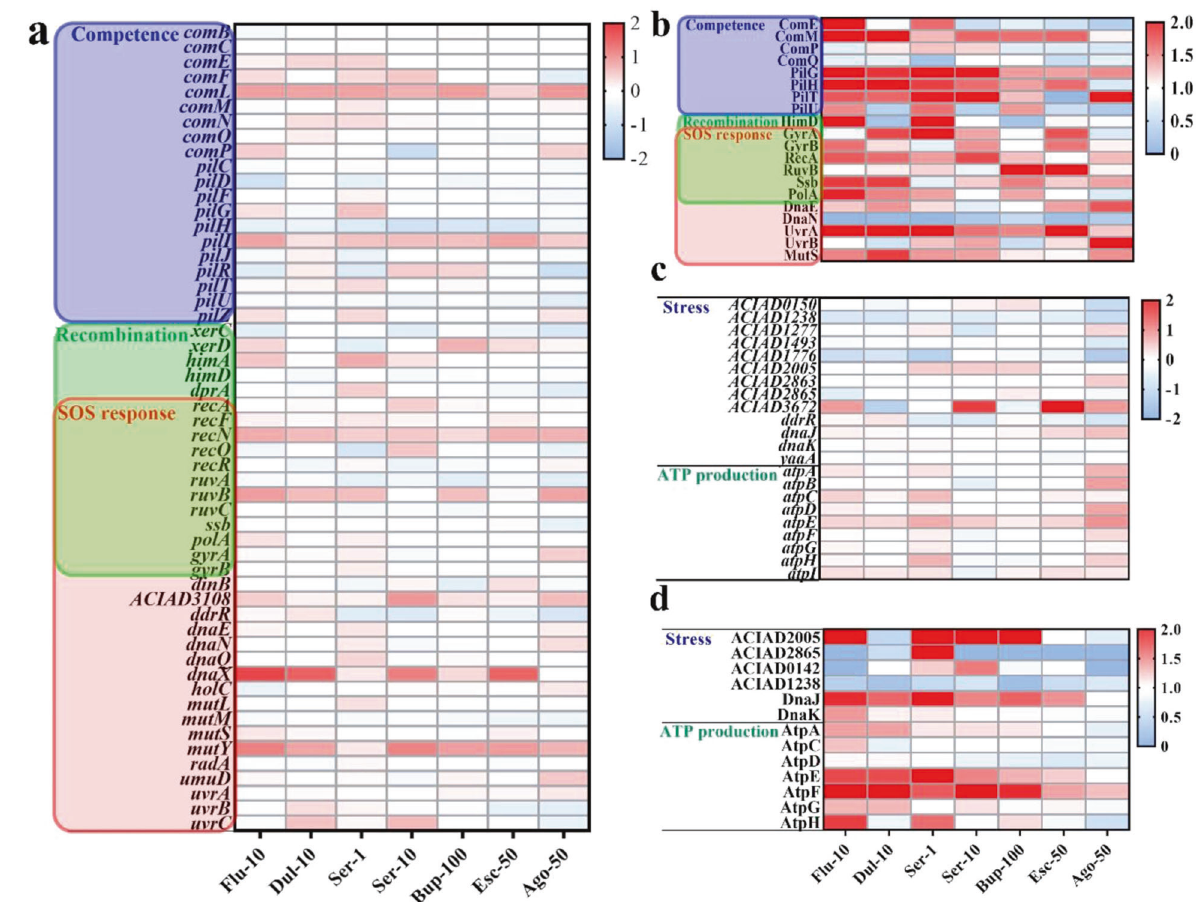
Fig. 4 Antidepressants regulate the transcription and translation of competence stress response, recombination, SOS-response and ATP genes. Heat-maps showing the transcriptional changes ( a ) and translational changes ( b ) of competence, recombination and SOS-response related genes; and transcriptional changes ( c ) and translational changes ( d ) of universal stress response and ATP production-related genes under the exposure to various antidepressants ( n =